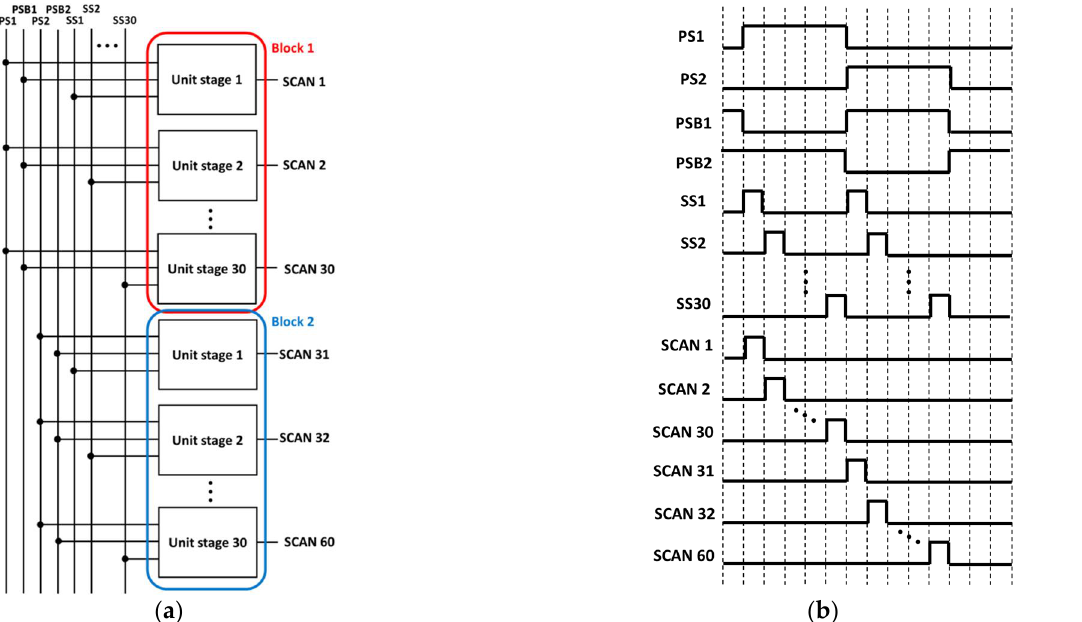
Figure 1. The unit stage ( a ) and timing chart ( b ) of the proposed scan driver.